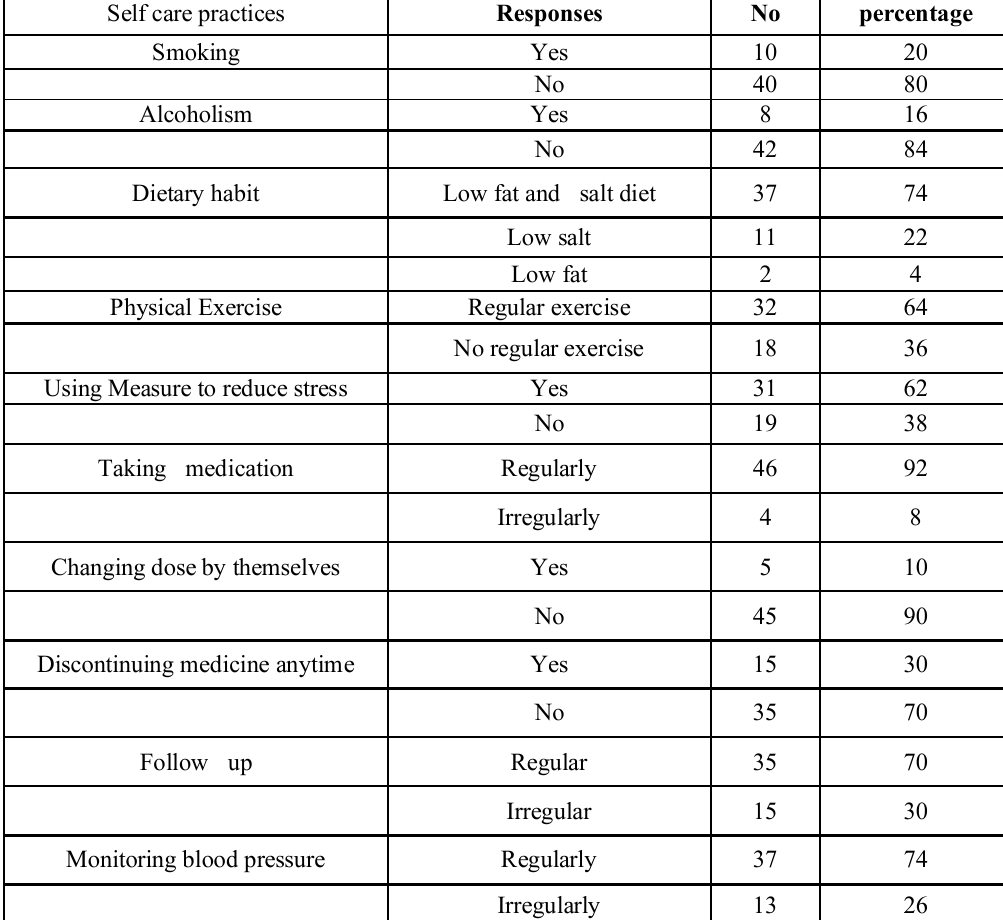
Table 3: Distribution of respondents about habit of doing self care (N=50) Self care practices